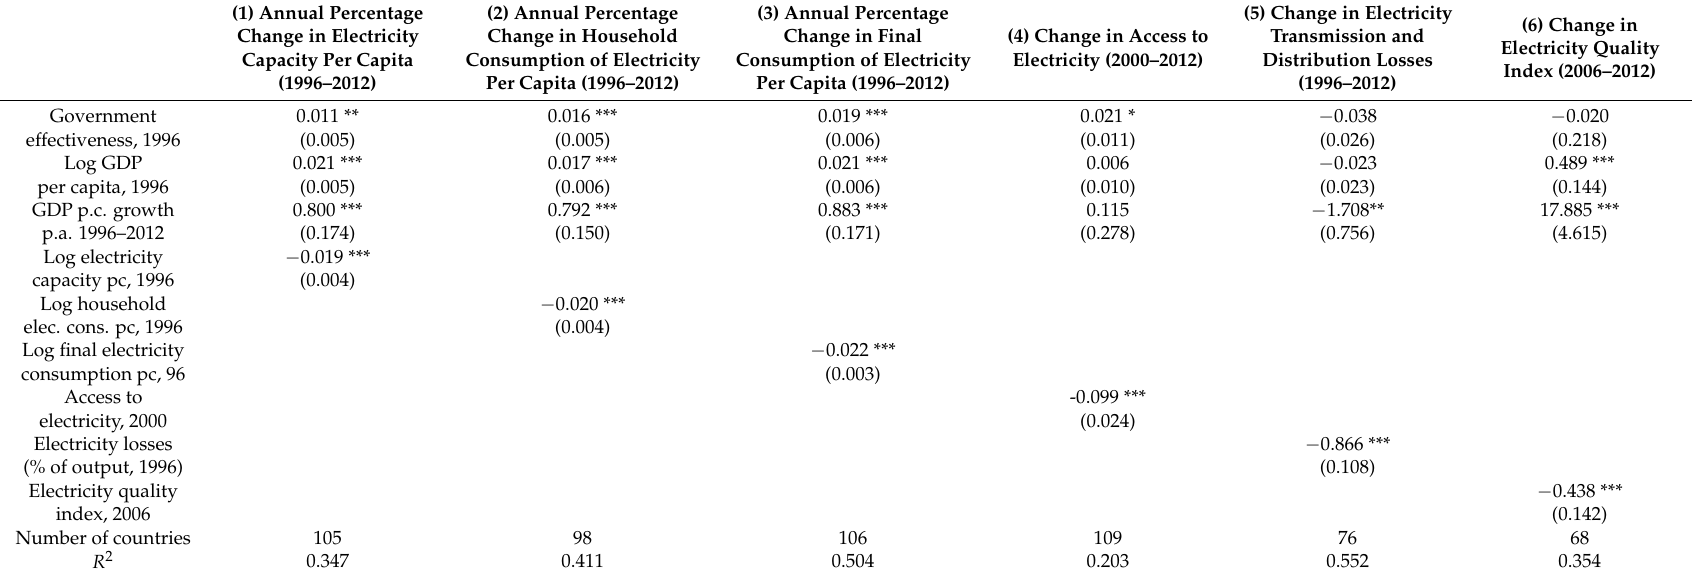
Table 5. Results, government effectiveness and change in electricity use, changes up to